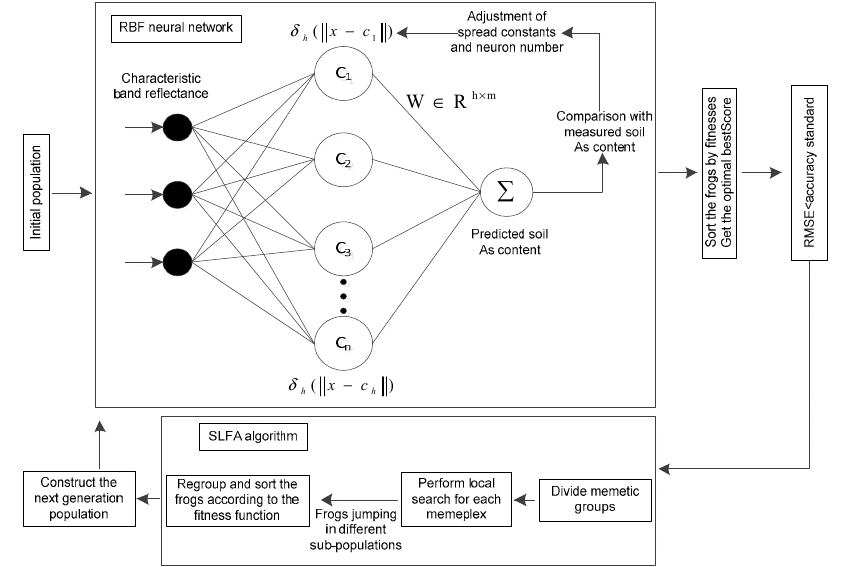
Figure 2. The structure of shuffled frog leaping algorithm optimization of the radial basis function neural network (SFLA-RBFNN).